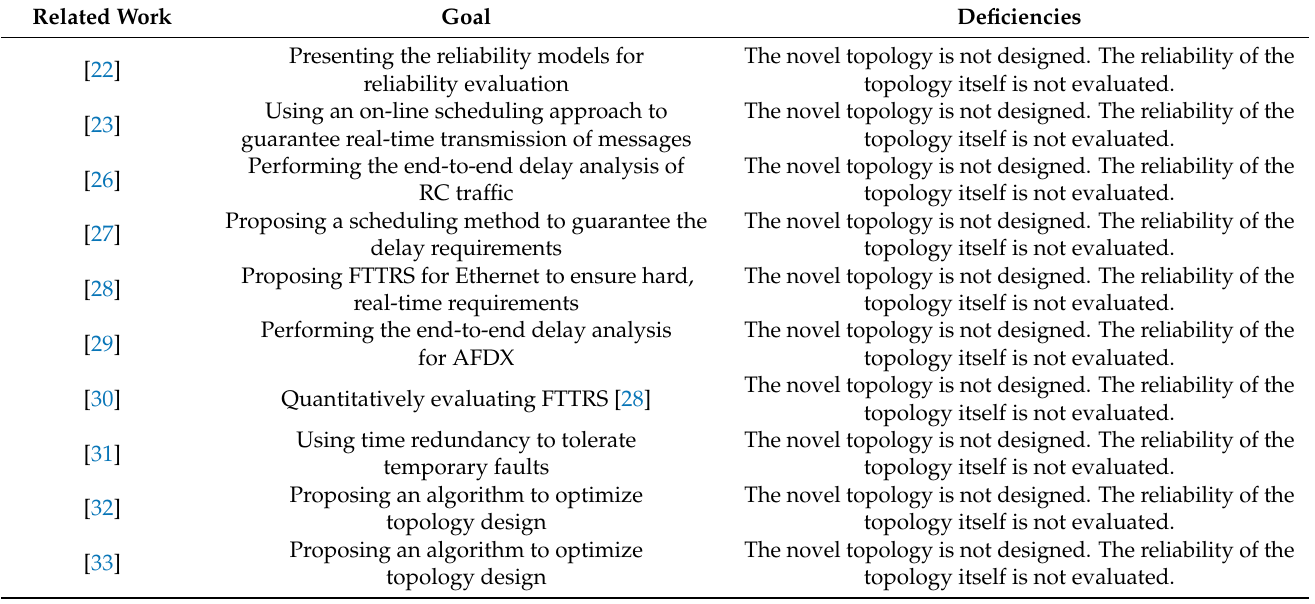
Table 1. Related works and their